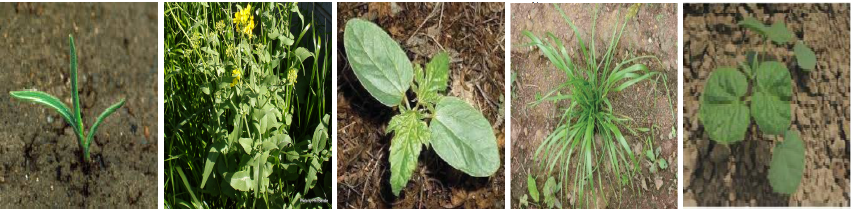
Figure 5. From left to right: Silky-bent, Turnip weed, Dicot, Grass Weed, Velvetleaf (Source: [41]).